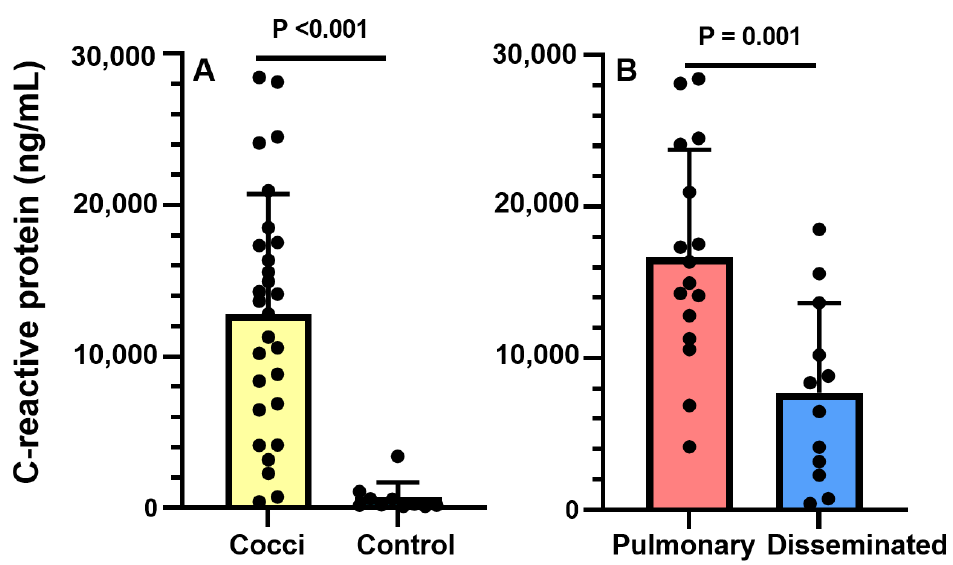
Figure 2. Comparison of serum C-reactive protein (CRP) concentrations between dogs with ( A ) coccidioidomycosis (n = 28) and healthy controls (n = 10) and ( B ) those with pulmonary (n = 16) and disseminated (n = 12) disease. Bars and error bars represent the mean and standard deviation, respectively. Enclosed circles represent individual data points. Dogs with coccidioidomycosis (mean, SD; 12,822 ng/mL, 7917) had higher serum CRP concentrations than controls (679.09 ng/mL, 1008.75, t(29) = − 7.94, p < 0.001). Dogs with pulmonary coccidioidomycosis (mean, SD; 16,659.51 ng/mL, 7091.89) had higher serum CRP concentrations than those with disseminated disease (7705.33 ng/mL, 5939.99, t(26) 3.63, p = 0.001).